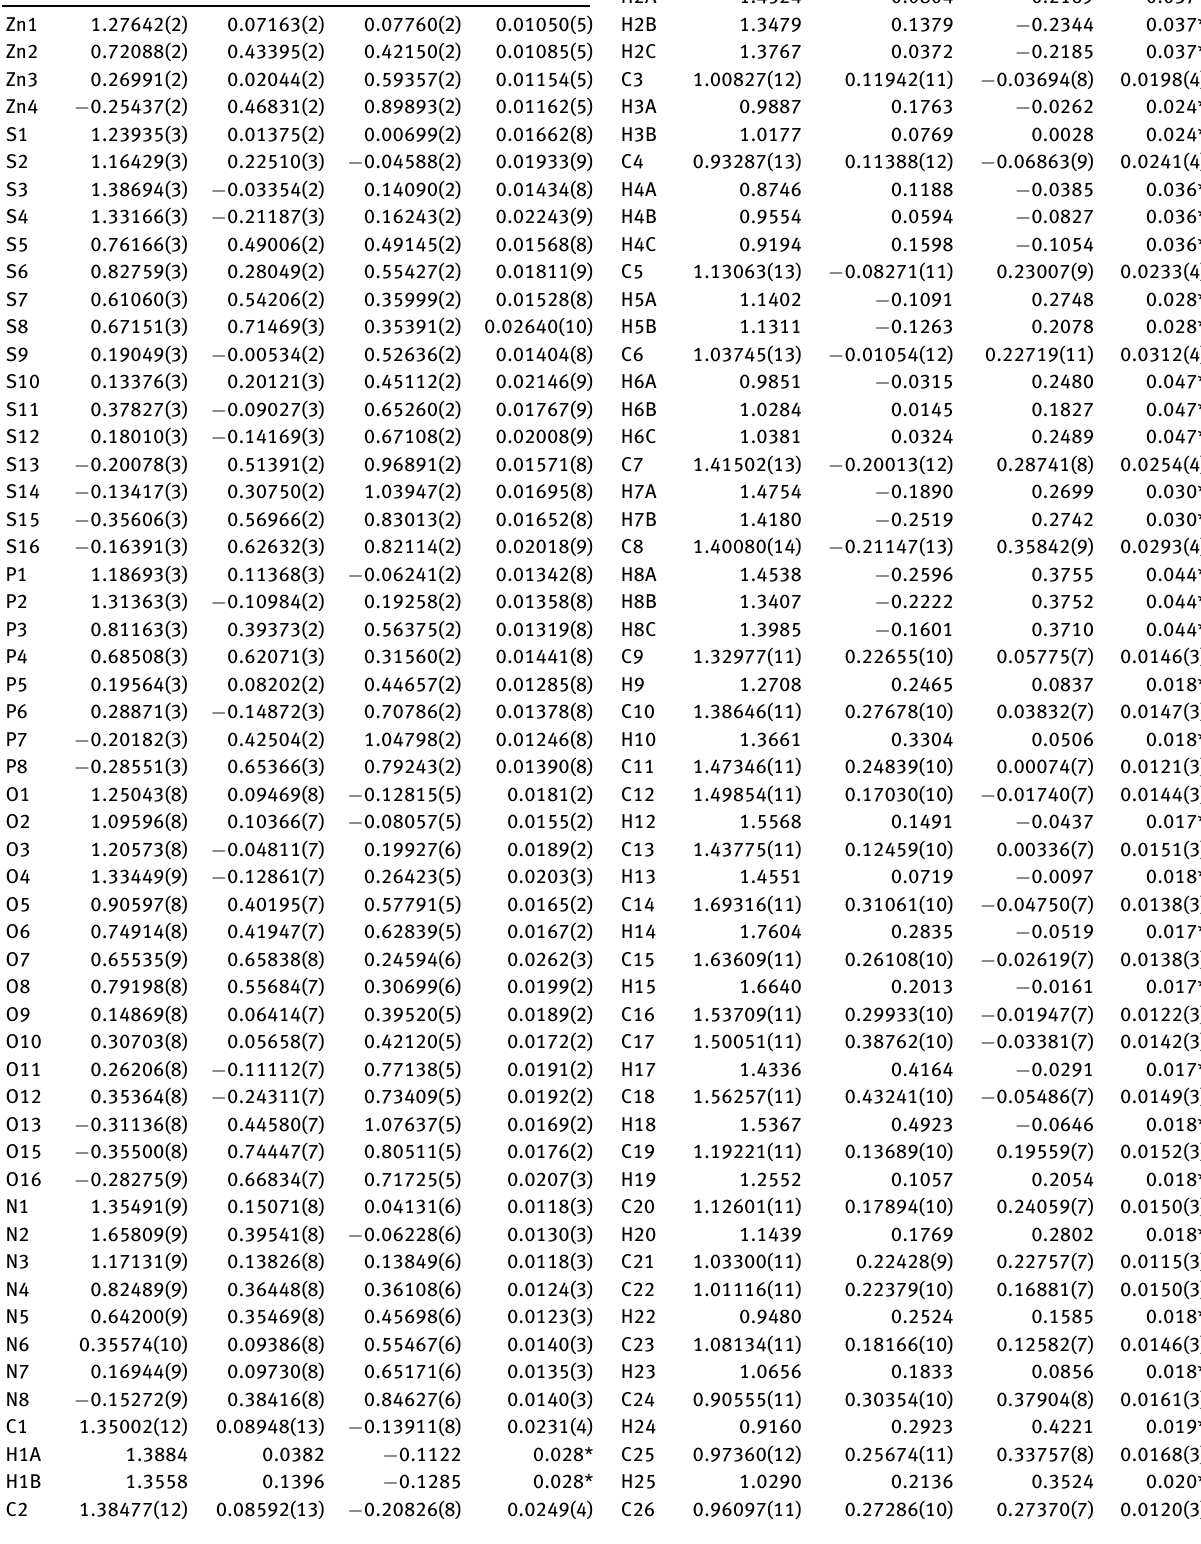
Table 2: Fractional atomic coordinates and isotropic or equivalent isotropic displacement parameters (Å 2